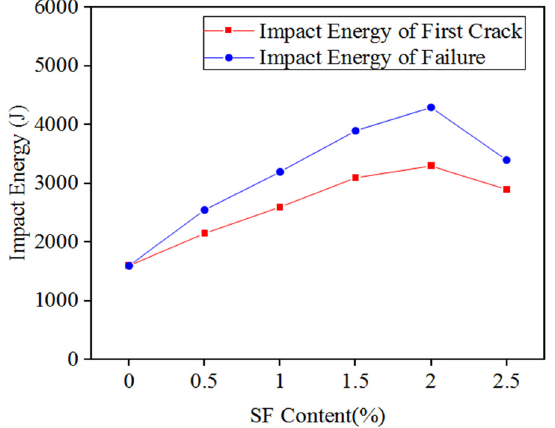
Figure 10: E ff ect of SF content on impact energy of concrete mixed with 3%